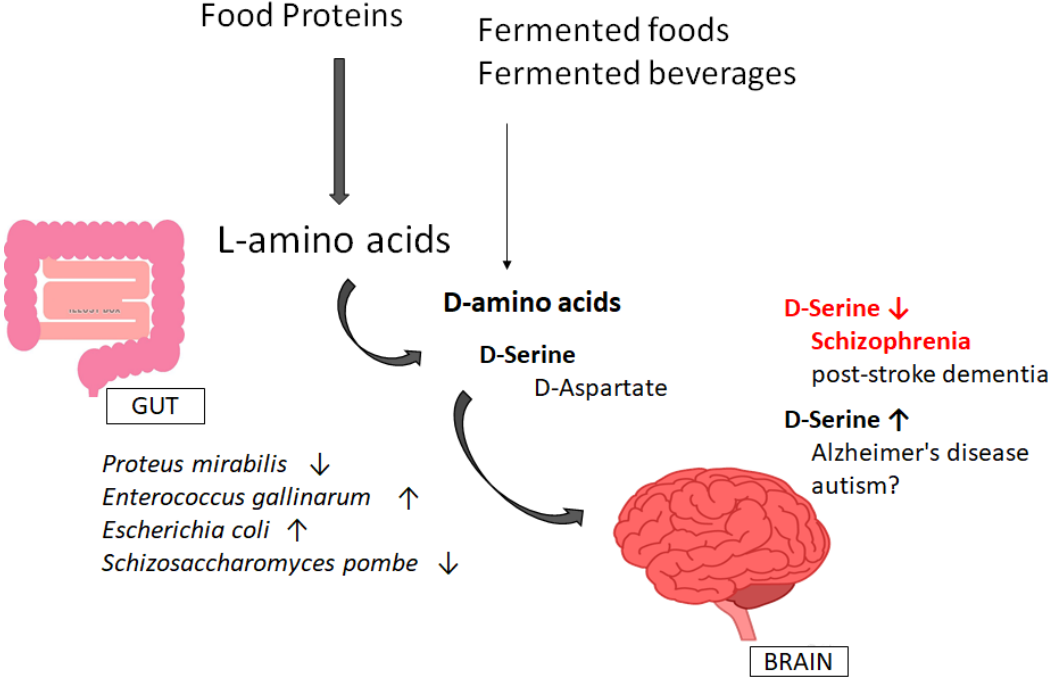
Figure 2. Gut microbiota might contribute to the creation or the destruction of the D-amino acids, which could play key roles in the pathological processes of psychiatric diseases. The bacteria shown here are instances that are involved in the increase ( ↑ ) or decrease ( ↓ ) of certain D-amino acid levels. Consequently, decreased levels of D-Serine may be associated with schizophrenia, whereas increased D-Serine levels might be found in Alzheimer ′ s disease. As a remark, critical events such as ROS production, cytokine induction, and immune activation have been omitted for simplicity.